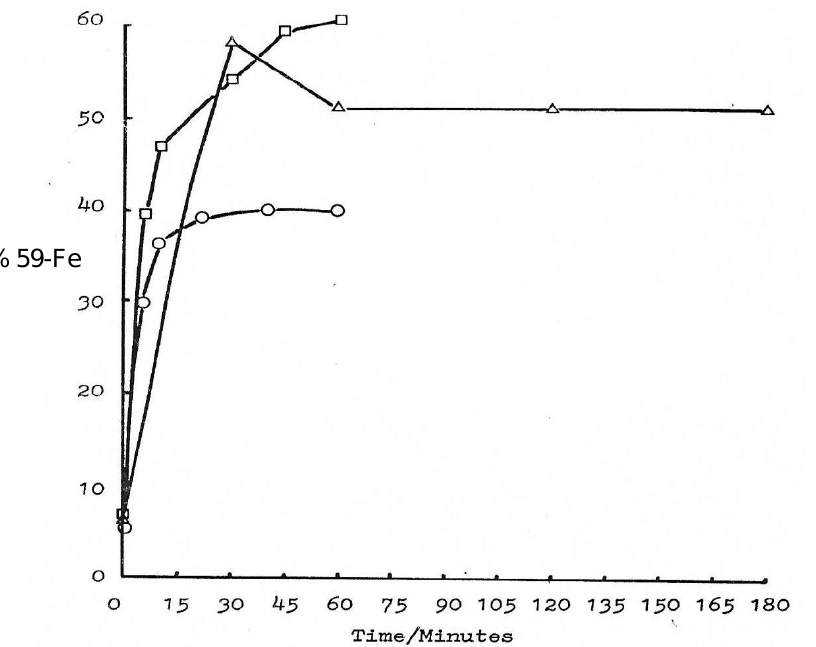
Figure 6. The transfer of iron by maltol in red blood cells. The rate of incorporation of the iron (59-Fe) in red blood cells was measured at different time intervals, following incubation with the iron (59-Fe) maltol complex at physiological pH. Three different experiments were carried out using different conditions including different buffers and variable maltol concentrations (0.5–4.0 mM) with molar excess ranging from 75 to 2800 times over iron [25].